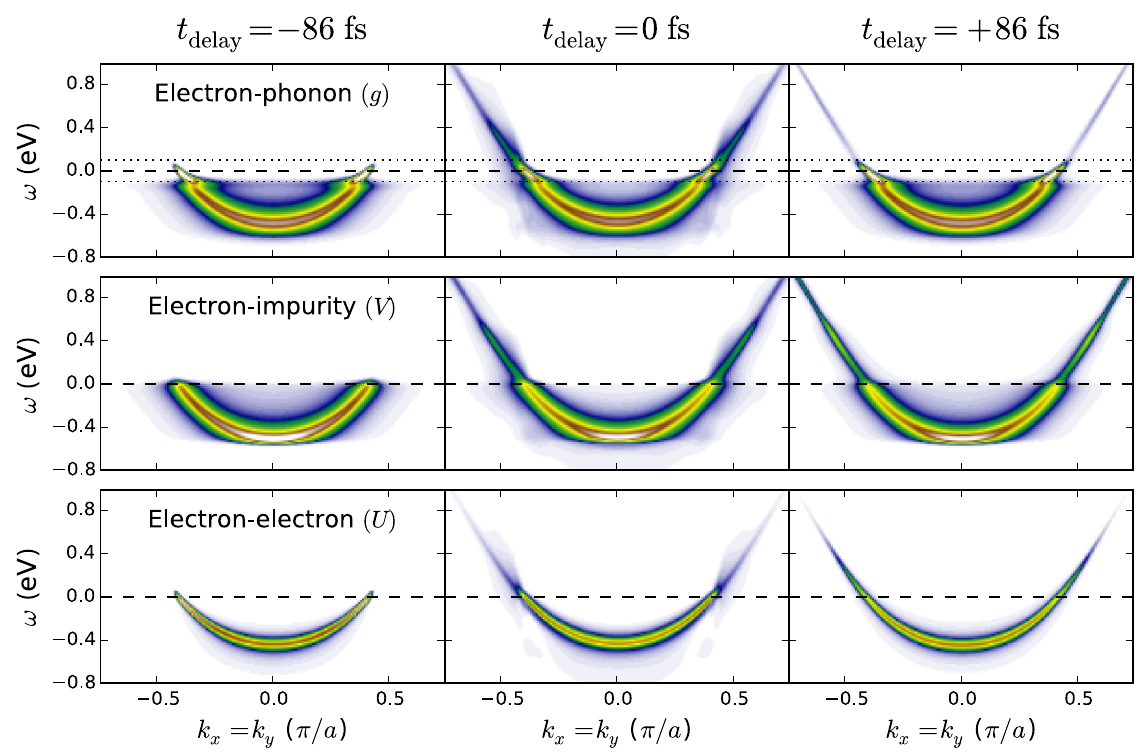
FIG. 3. False-color images of time-resolved single-particle spectral functions at the start of (left), during (middle), and after (right) the pump for the individual electron-phonon, electron-impurity, and electron-electron interactions. Here, the interaction strengths are